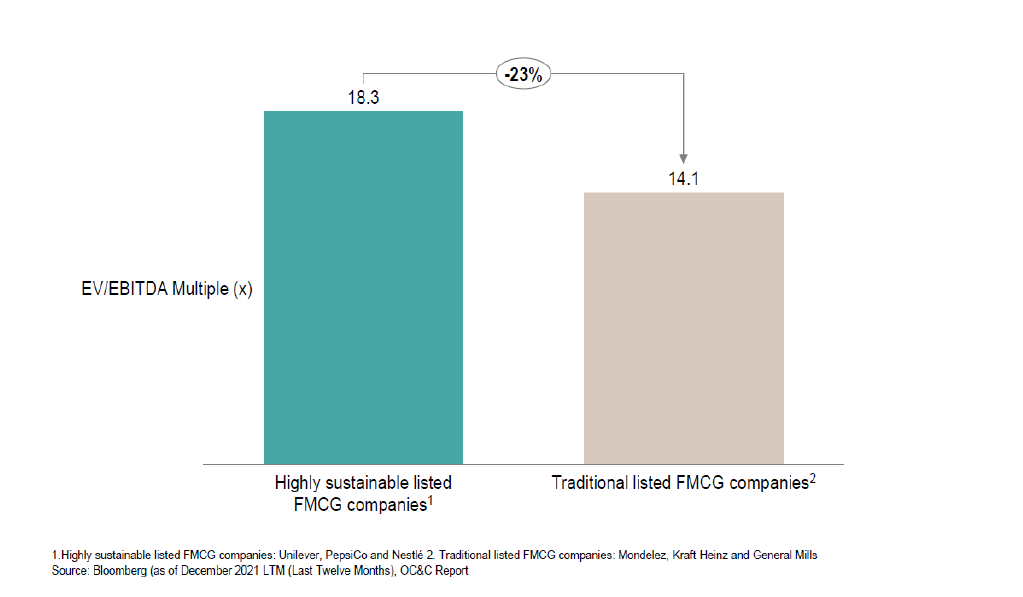
Figure 5: Multiples of Companies with Sustainable